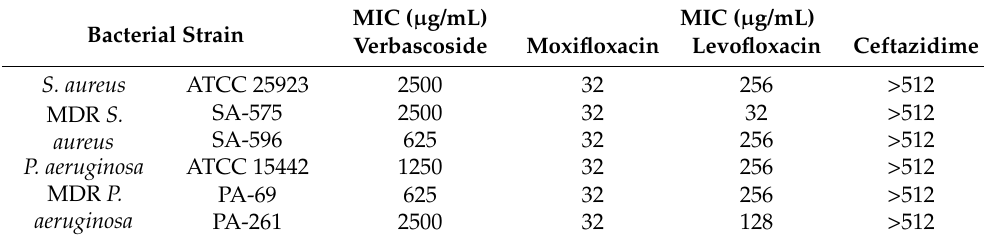
Table 1. Antimicrobial activity expressed as the minimal inhibitory concentration. MIC ( µ g/mL) MIC ( µ g/mL) Bacterial Strain